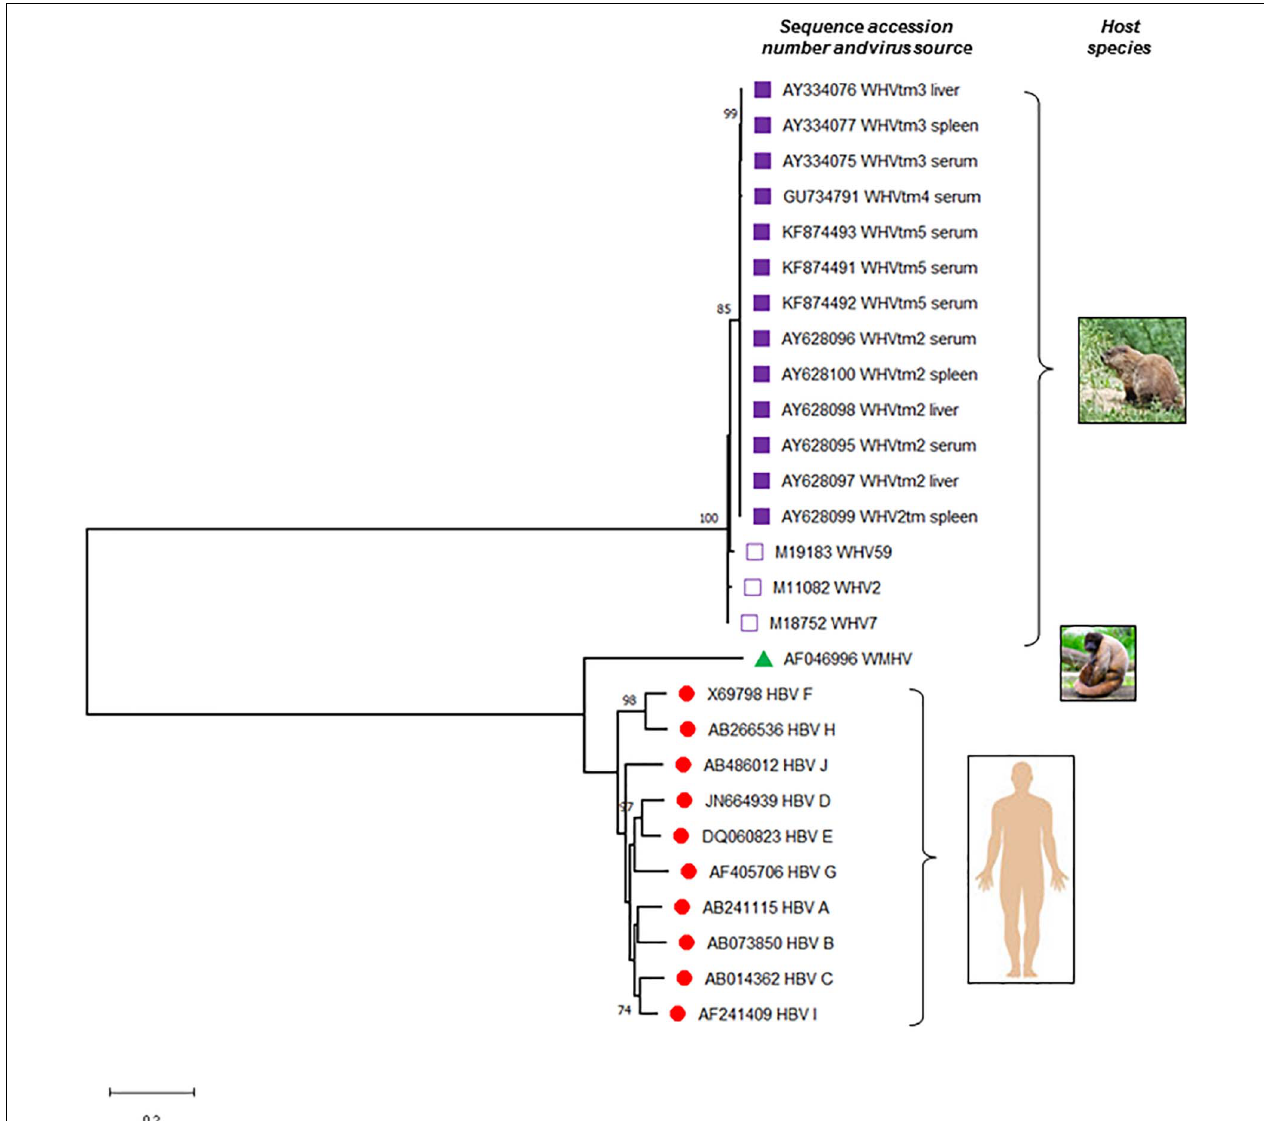
FIGURE 2 | Phylogenetic tree of the nucleotide sequences illustrating the evolutionary relationship between hepatitis B virus (HBV) and woodchuck hepatitis virus (WHV). Complete sequences of all 10 known HBV genotypes (A to J), woodchuck hepatitis virus (WHV) identified at different locations of the virus natural occurrence, and a representative sequence of wooly monkey hepatitis virus (WMHV) were included. Full genomic sequences of WHVtm2, WHVtm3 WHVtm4, and WHVtm5 were obtained after clonal sequencing, while those of WHV2, WHV7, and WHV59 by traditional Sanger sequencing. If the source material of virus was not listed, serum or plasma was used to isolate viral DNA sequenced. The sequences and their accession numbers obtained from GenBank (National Center for Biotechnology Information, National Library of Medicine, Bethesda, MD, United States) are indicated. Sequences were aligned using MAFFT and the trees were generated using MEGA software version X (www.megasoftware.net). For the analysis, the Maximum Likelihood method and General Time Reversible (GTR) model with Gamma distribution (+ G , parameter = 0.6290) were used. The tree with the highest log likelihood (–17303.75) is shown. Only bootstrap values of above 70% are shown and distance scale bare is included. Gaps and missing data were eliminated leaving of 2968 positions in the